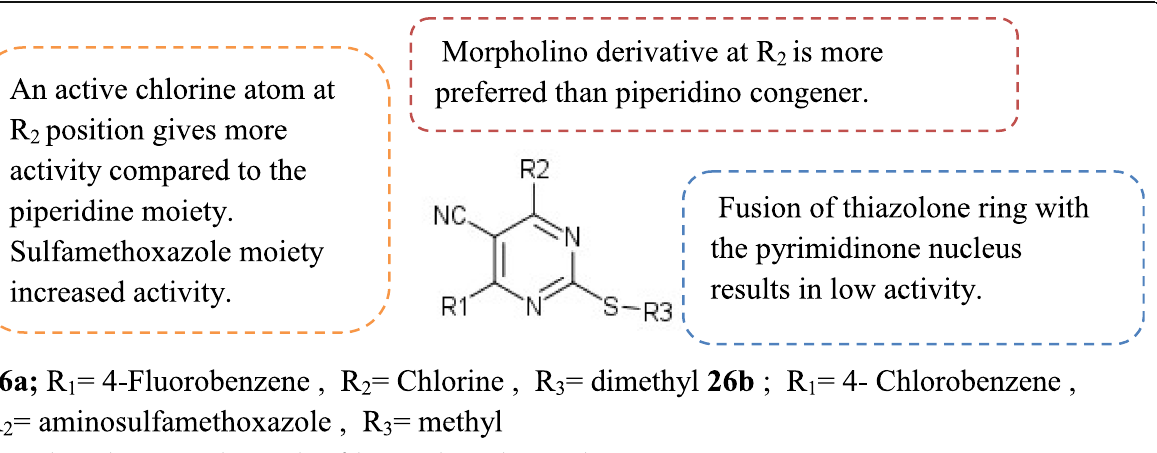
Fig. 10 Chemical structure and SAR studies of thiopyrimidine analogs 26(a – b)